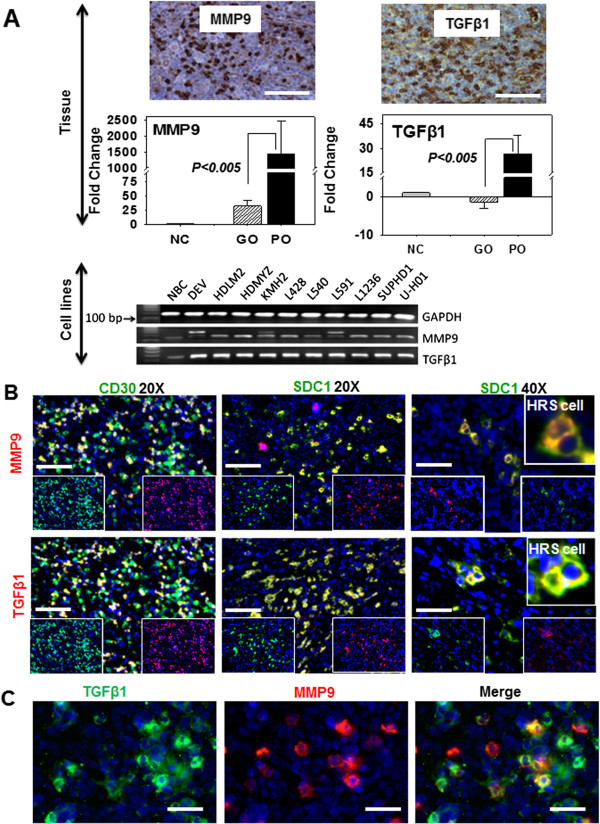
Metastatic markers TGFβ1 and MMP9 are overexpressed in poor outcome HL patients and by HL cell lines. (A) Protein and mRNA expression levels of TGFβ1 and MMP9 in normal lymph node control (NC), good outcome (GO) group and poor outcome (PO) group analyzed by immunostaining (left, images only for PO group) and qRT-PCR (right). mRNA expression is represented by fold-change (y-axis) after normalization with the control (NC). Significance of all qRT-PCR data comparing GO and PO is indicated (p < 0.005). TGFβ1 and MMP9 are also overexpressed by the HL cell lines (lower image of gel electrophoresis of (A)). (B) TGFβ1 and MMP9 protein coexpression in tissues from the poor outcome HL patient group analyzed by double immunofluorescence staining for CD30, TGFβ1 and MMP9, or SDC1, TGFβ1 and MMP9. Individual green or red fluorescence is depicted at the bottom of each image. (C) Coexpression of TGFβ1 and MMP9 by subsets of tumor cells in poor outcome sample. (Inset of A and B) Hodgkin Reed Sternberg cells (HRS) coexpressing SDC1 and TGFβ1 or SDC1 and MMP9. Scale bar (white solid bar) represents 100 μm.